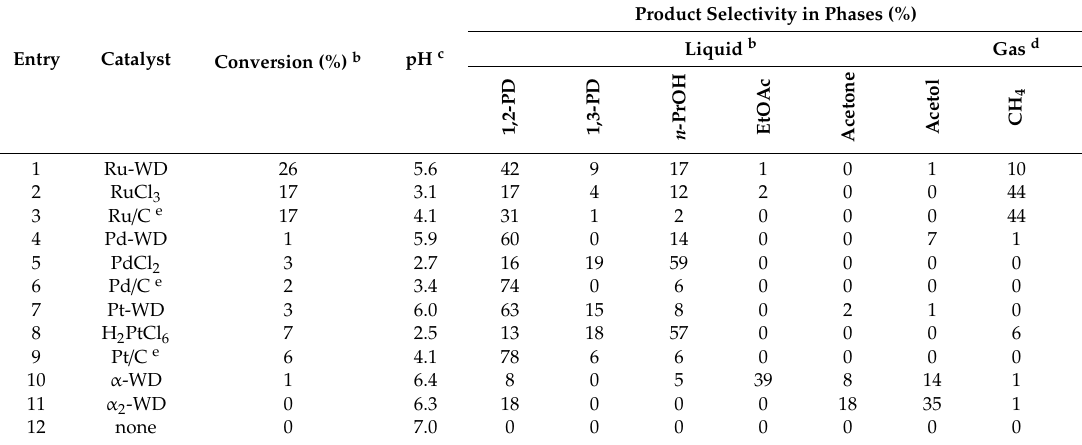
Table 1. Catalytic performance of WD-based catalysts and other metal-based catalysts in glycerol (GL) hydrogenolysis a